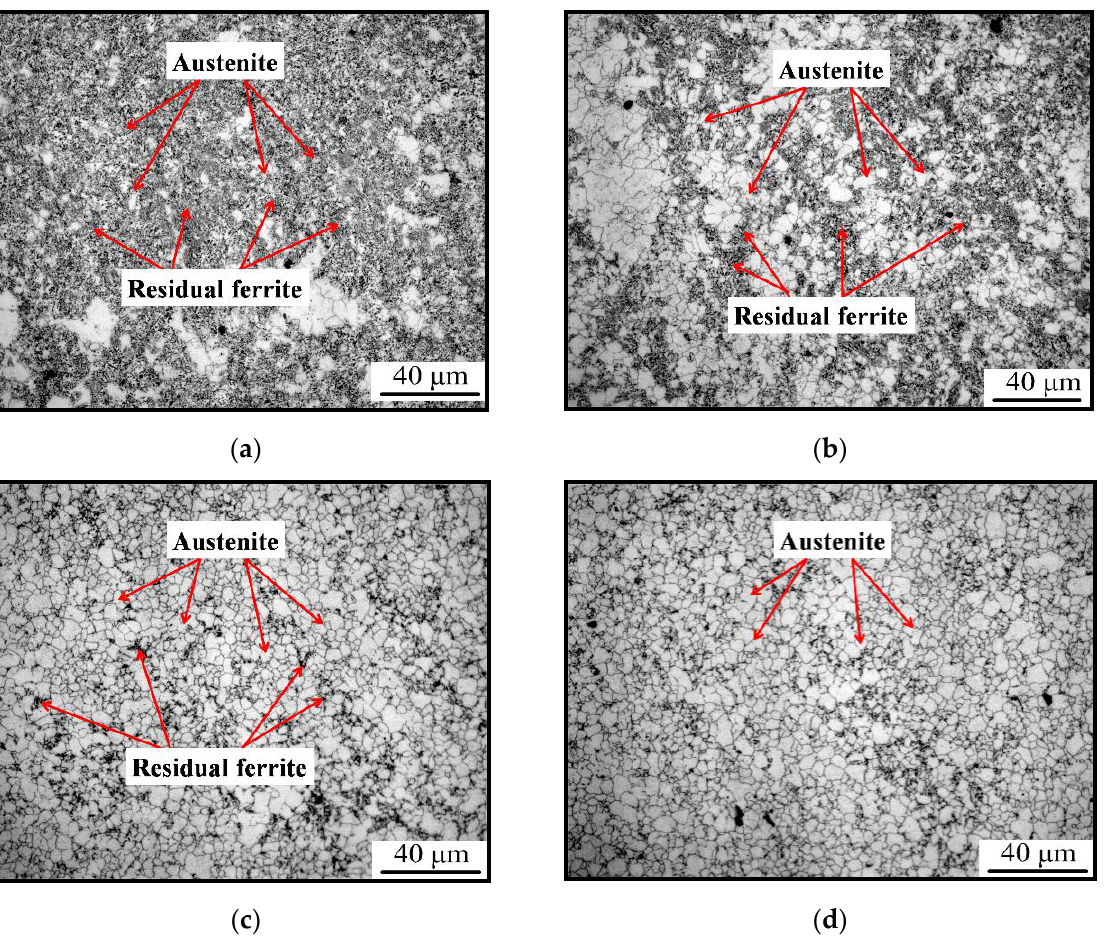
Figure 4. Austenite grain after different passes: ( a ) after 3rd pass, ( b ) after 4th pass. ( c ) after 5th pass, ( d ) after 6th pass.